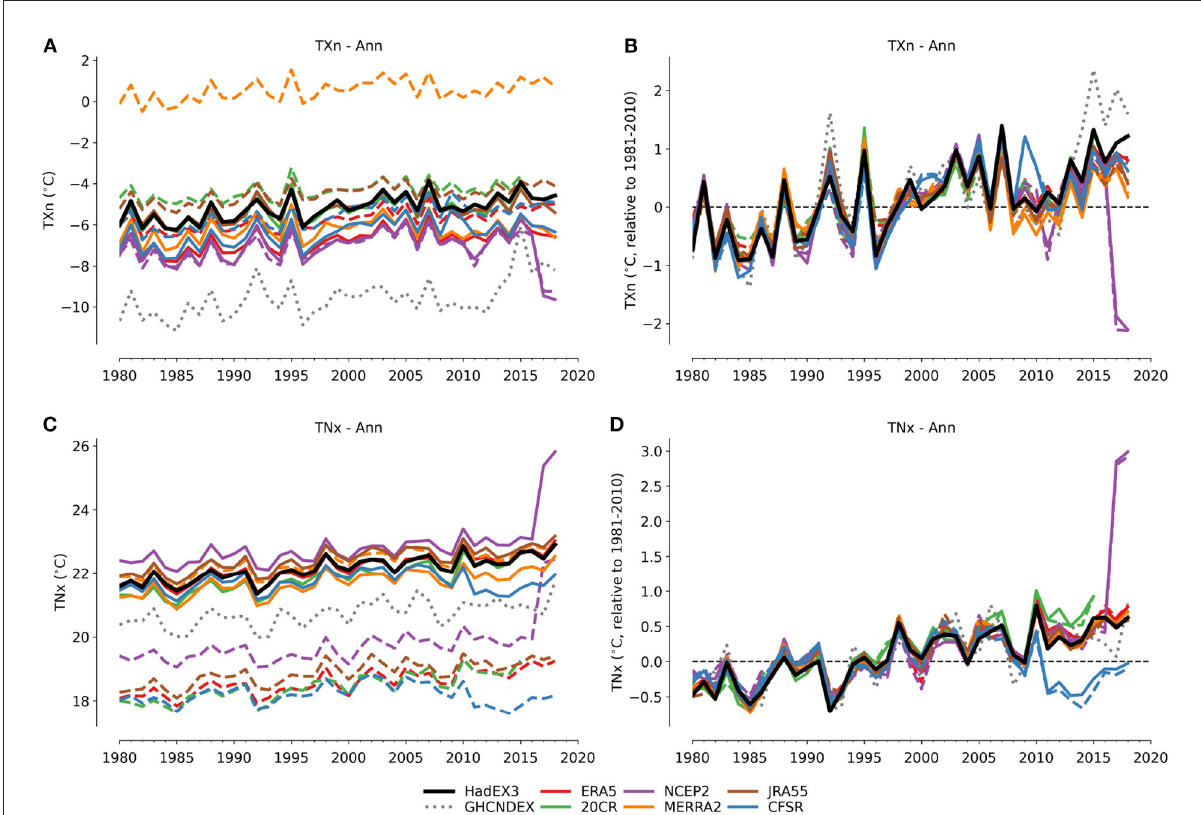
FIGURE1 Time series of absolute values (A,C) and anomalies (relative to 1981–2010), (B,D) of TXn (minimum Tmax) and TNx (maximum Tmin). The dashed lines are for reanalyses using complete global land coverage, the solid ones are matched to the spatio-temporal coverage of HadEX3.